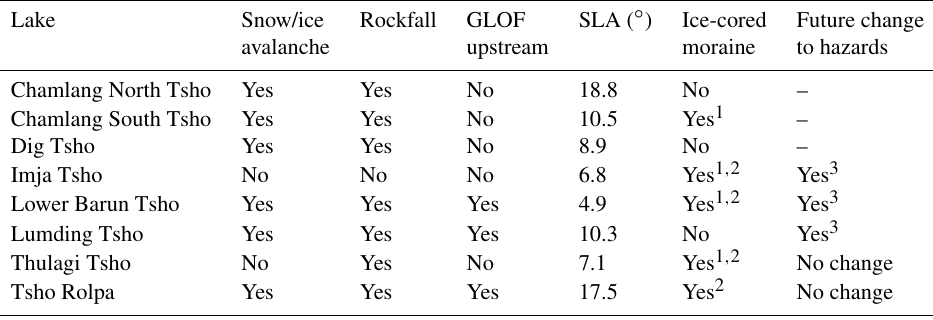
Table 5. Summary of the hazard parameters for the studied glacial lakes.